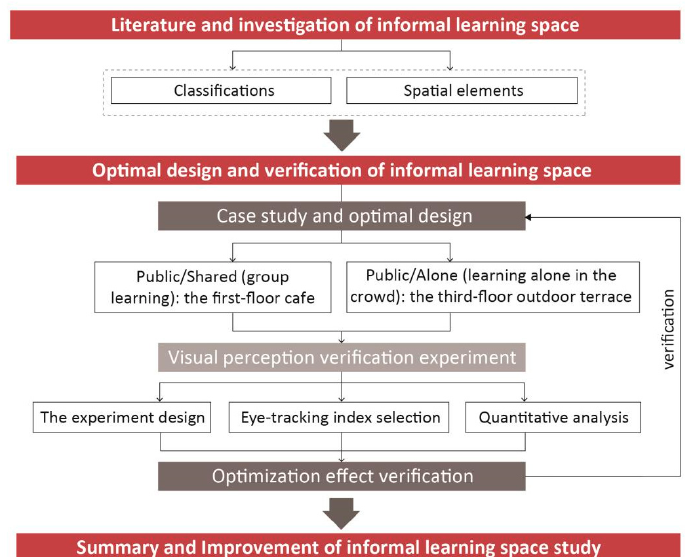
Figure 1. Framework of the research.